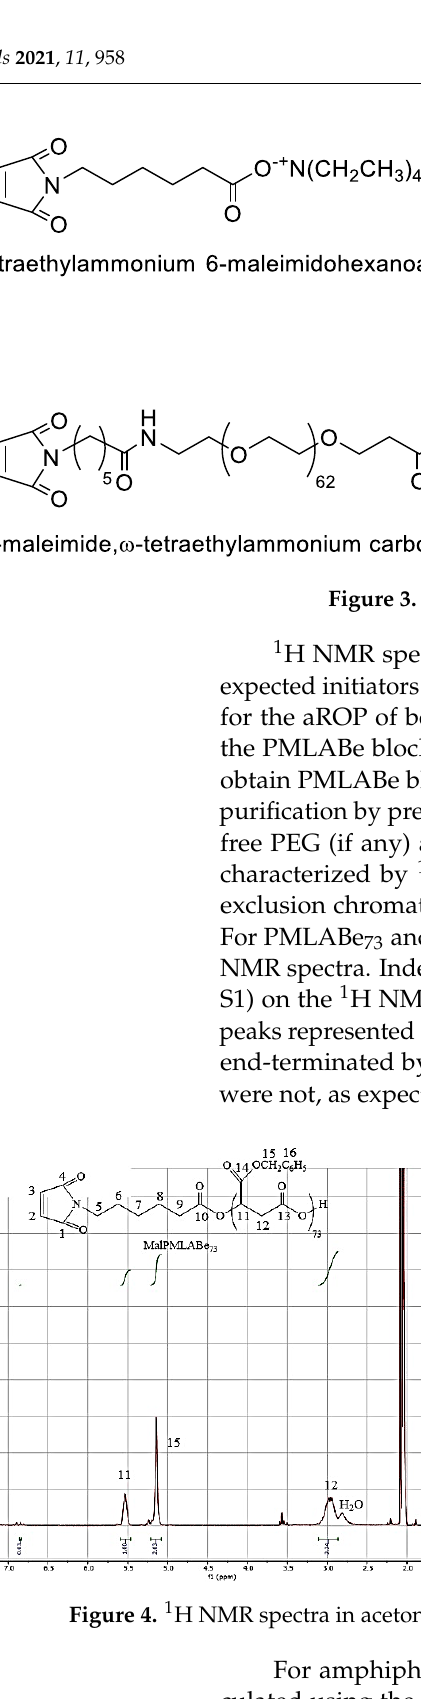
Figure 4. 1 H NMR spectra in acetone-d 6 of: ( A ) MalPMLABe 73 , and ( B ) MalPEG 62 - b -PMLABe 73 .